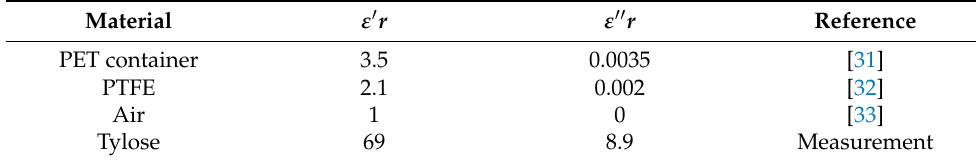
Table 2. Dielectric properties of materials at 915 MHz.